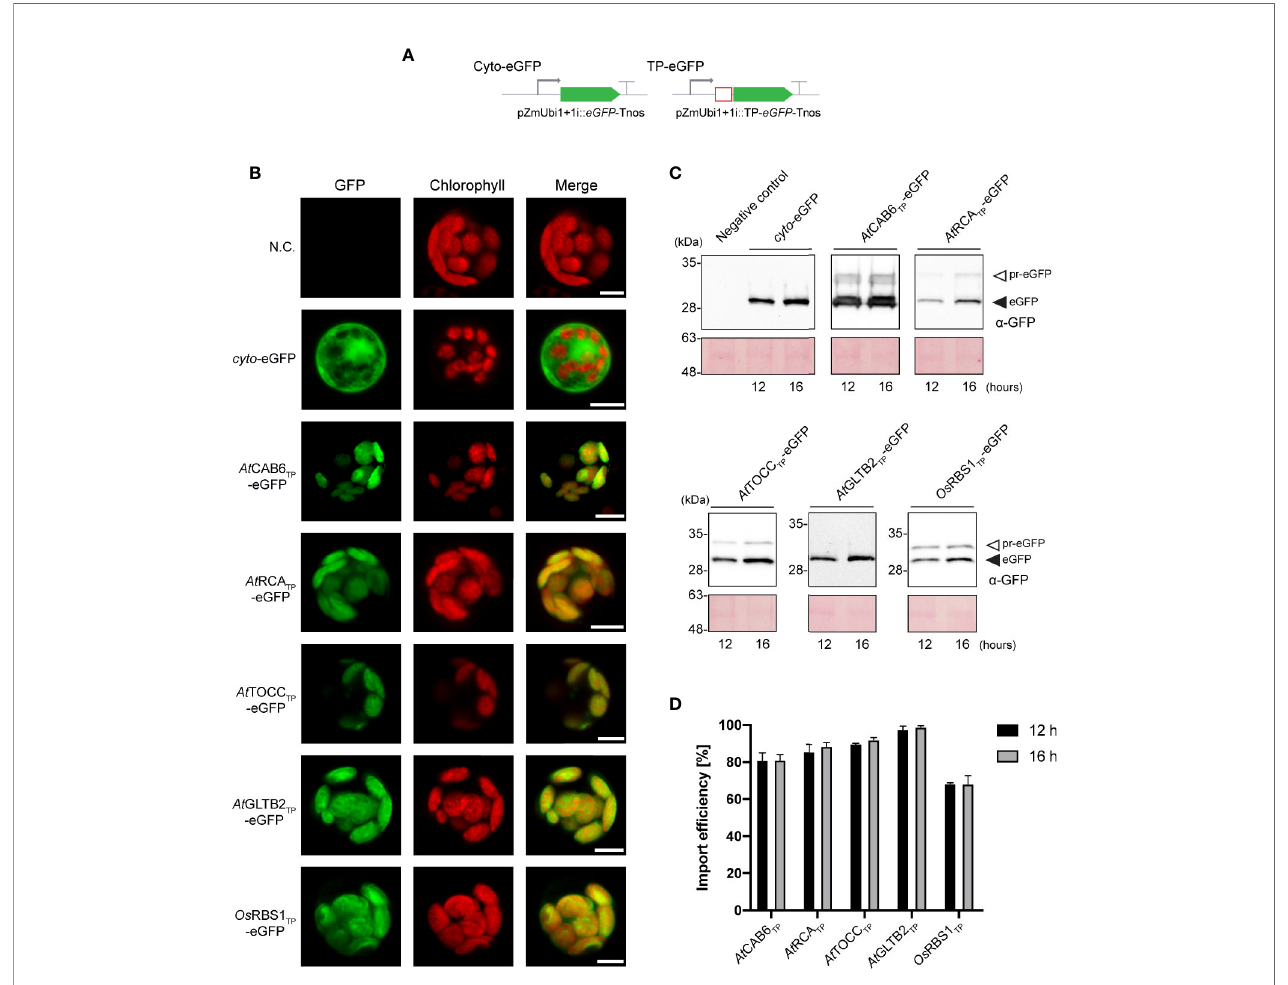
FIGURE 3 | Arabidopsis transit peptides (TPs) are able to direct eGFP into rice chloroplast. (A) Schematic representation of the constructs used in O. sativa transient expression assays leading to eGFP expression and localization. (B) Confocal laser scanning microscopy images of rice protoplast expressing indicated TP- eGFP fusions. N.C. corresponds to “ Negative Control ” , nontransformed protoplasts. The three columns show individual signals for eGFP (green, on the left), chlorophyll auto fl uorescence (red, in the center) and overlap of both signals (right). Scale bars = 5 µm. ( C) Western-blot analysis of import experiments. Protoplast isolated from rice were transformed with indicated TP-eGFP fusions and total protein extracts were analyzed by western blotting using anti-GFP antibody. The experiments were performed in three biological replicates and representative data is shown. White arrows (pr-eGFP) indicate precursor form; black arrows (eGFP) indicate, processed form. (D) Quanti fi cation of import ef fi ciency of TPs into rice chloroplast. Import ef fi ciency was de fi ned as the percentage of the processed faster- migrating protein form relative to the total amount of expressed eGFP protein in each line. Data represent means (n = 3) with